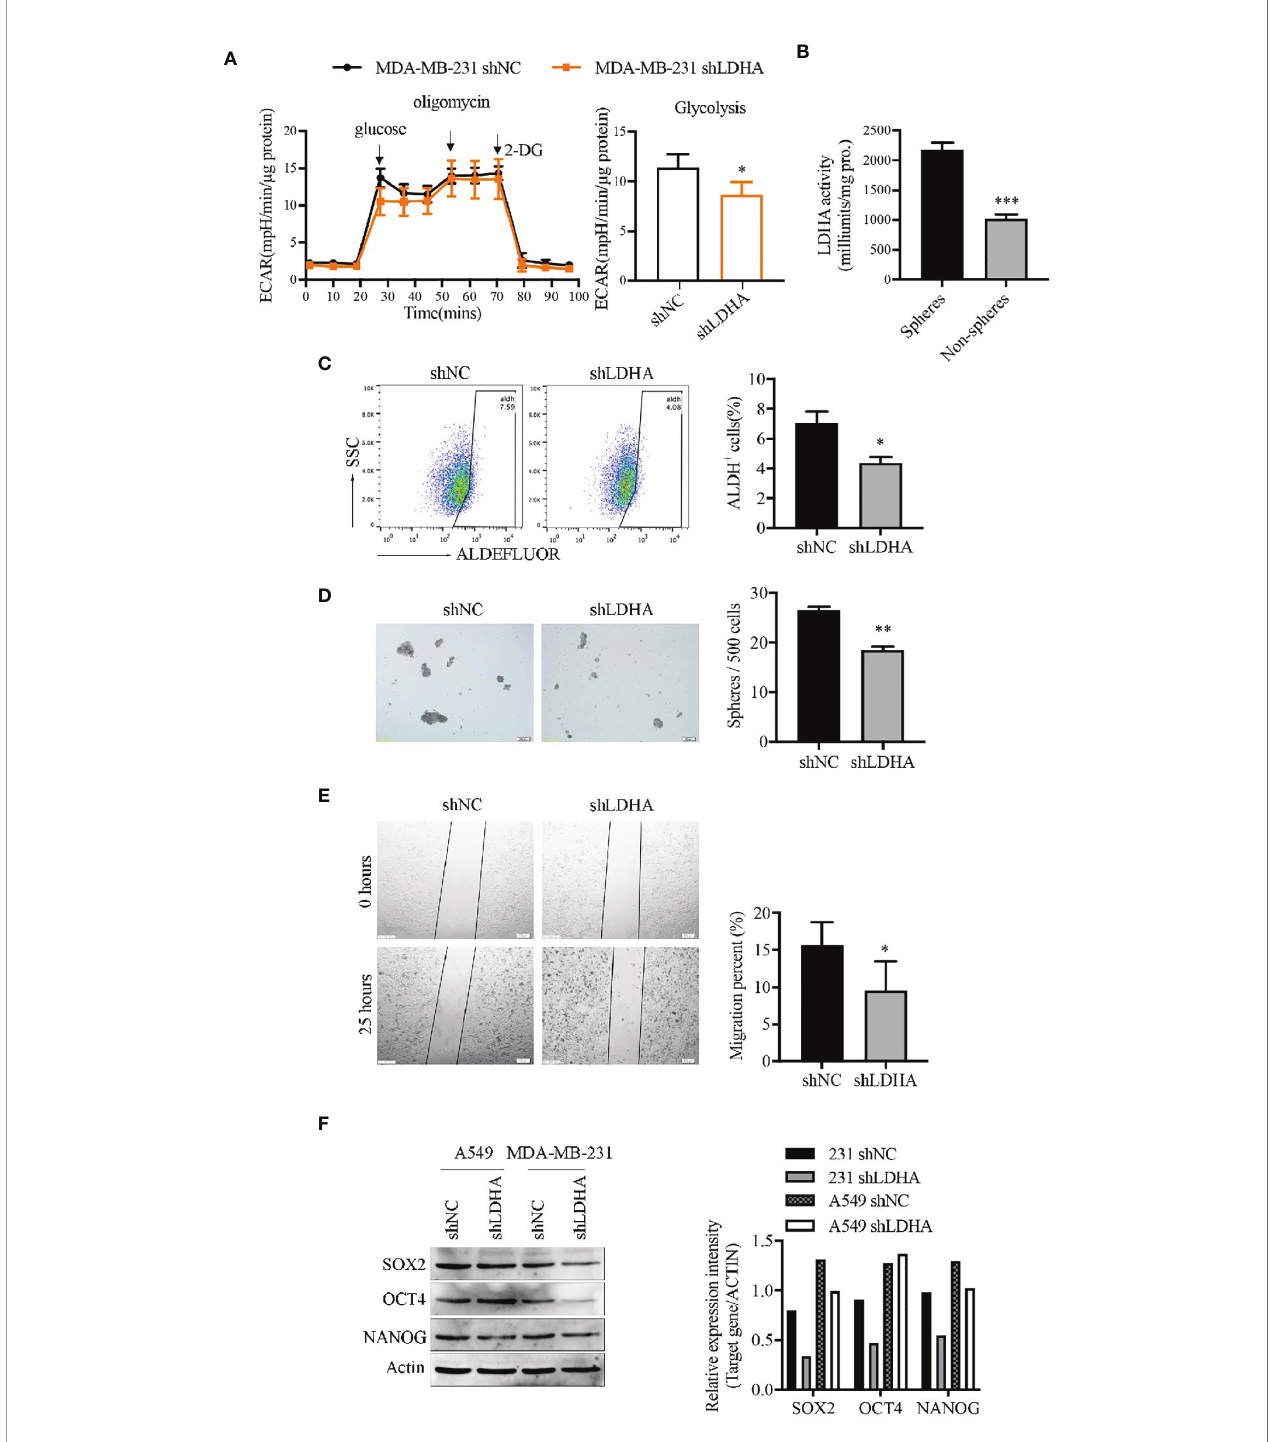
FIGURE 2 | LDHA maintained stemness properties of human breast cancer cells. (A) Extracellular acidi fi cation rate (ECAR) of MDA-MB-231-shLDHA or control cells was detected by Seahorse Cellular Bioenergetics Analyzer. (B) LDH activity was detected in spheres or non-spheres cancer cells of MDA-MB- 231 by colorimetry. (C) Percentage of ALDH + cells in MDA-MB-231-shLDHA or control cells was analyzed by fl ow cytometry. (D) MDA-MB-231-shLDHA or control cells was cultured in sphere formation medium for 5-7 days, and the numbers of tumor-spheres were counted under a microscope. The representative images of spheres were shown on the left. Scale bar, 200 m m (insets). (E) Ability of cellular migration was measured by wound healing assay in MDA-MB-231 shNC and shLDHA cells. (F) Western blot analysis for SOX2, OCT4 and NANOG in A549-shLDHA, MDA-MB-231-shLDHA and their control cells. * P < 0.05; ** P < 0.01; *** P <